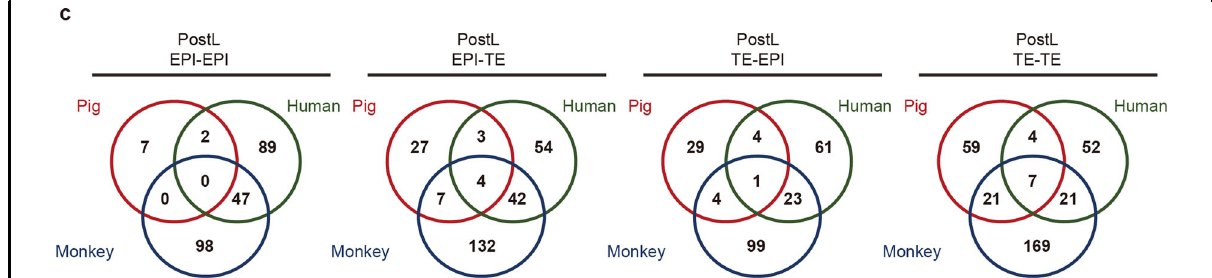
Fig. 5 Cross-species comparison of membrane-related genes among pig, monkey and human EPIs. c Overlaps of the interaction relationship between PostL-EPIs and PostL-TEs in each species. A total of 59, 52, and 169 pairs were predicted to be unique between Post-TEs (TE – TE) in pig, human, and monkey,